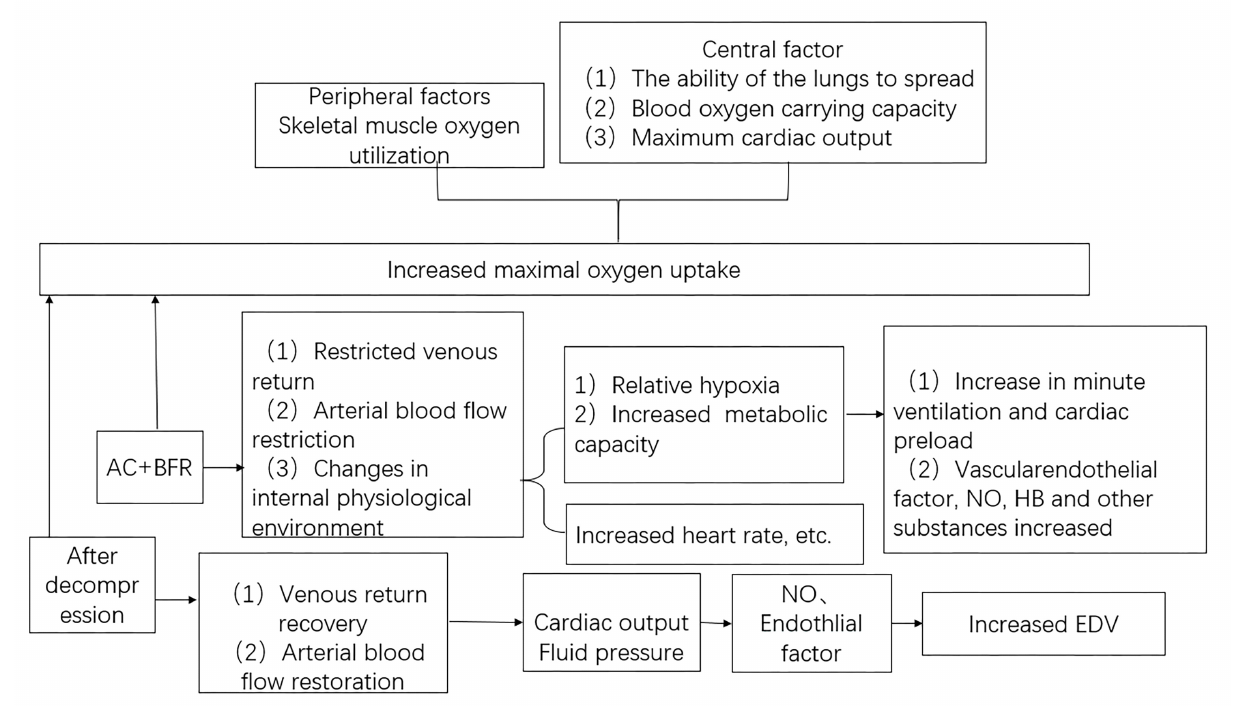
Fig. 7. Potential mechanism for improving aerobic capacity during and after the intervention of blood flow restriction